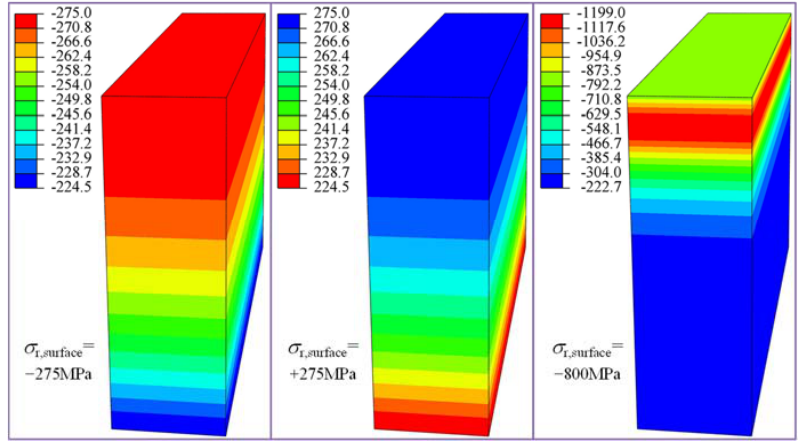
Figure 15. The actual residual stress after equilibrium (without external load).